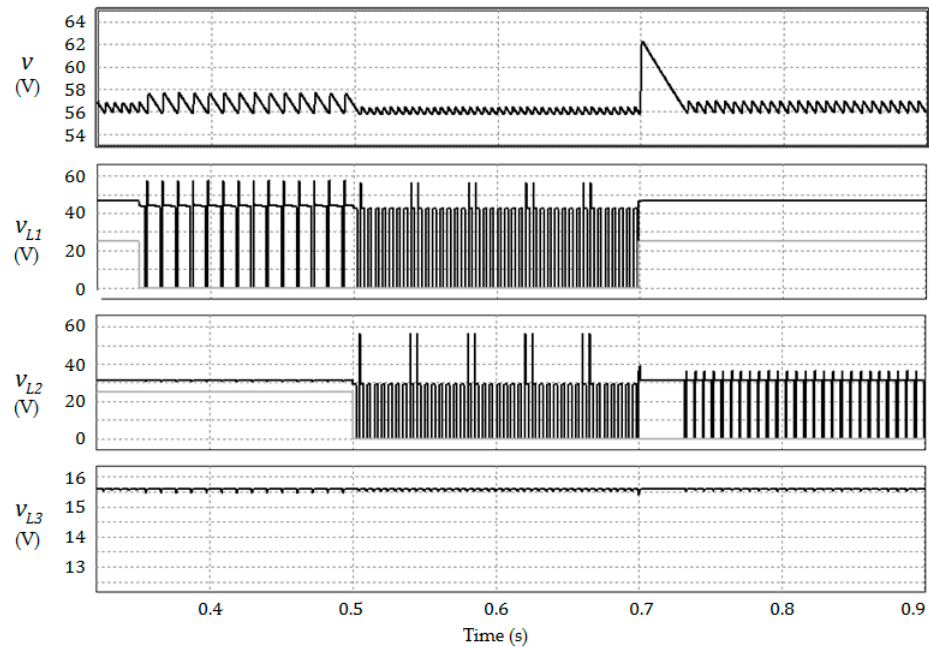
Figure 5. PI closed-loop behavior with L 1, L 2 open circuits to 0.35 and 0.5 s respectively. v L 1 to v L 3 are the voltages in the respective inductor.